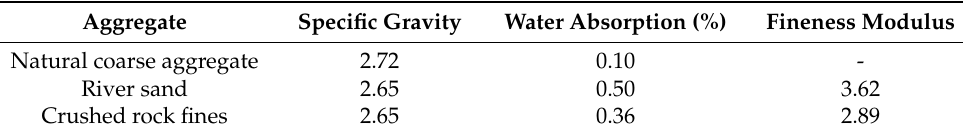
Table 2. Physical properties of aggregates.